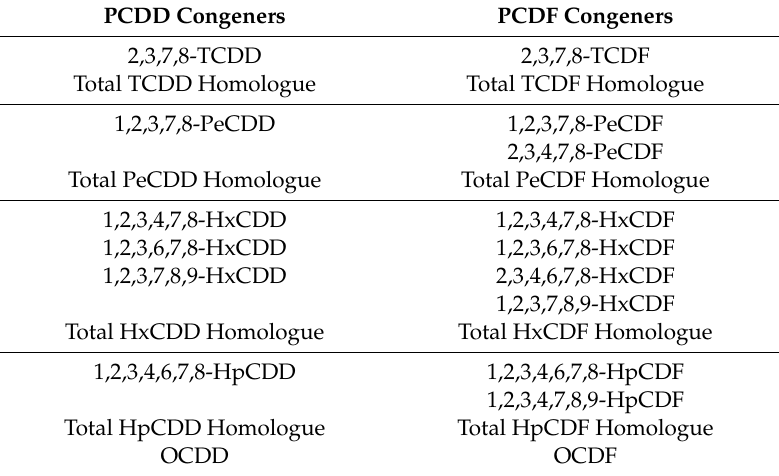
Table 2. Polychlorinated Dibenza-p-dioxins (PCDDs) and Polychlorinated Dibenza-p-furans (PCDFs) determined in each sediment sample